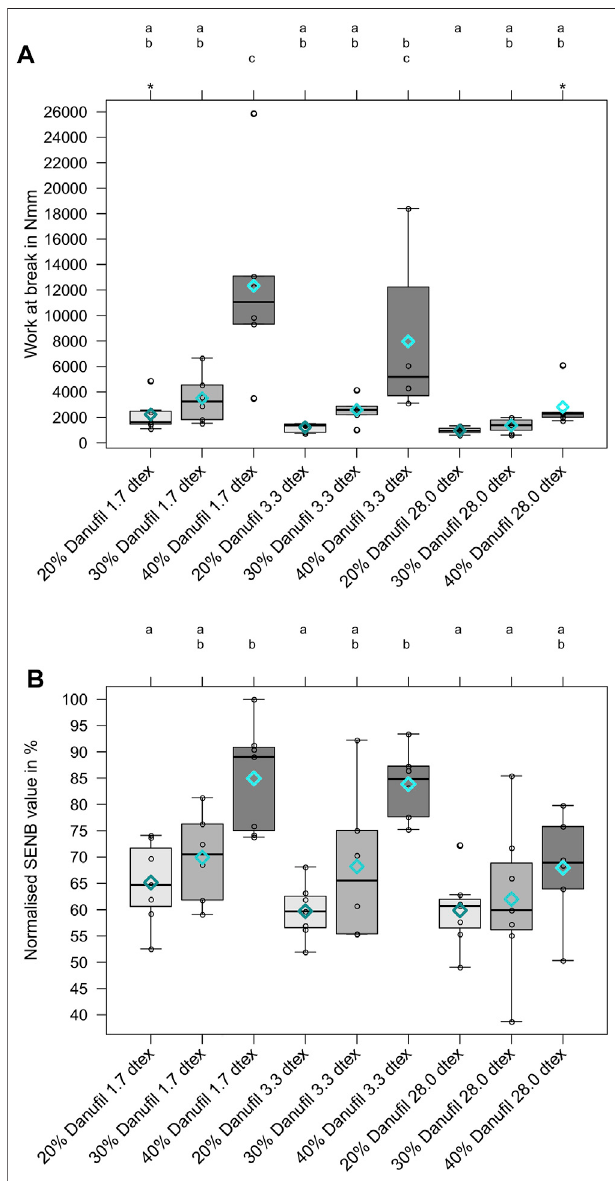
FIGURE 7 | Work at break determined from force-displacement curves of tensile tests (A) and SENB value normalised to the highest value obtained by a single edge notched bending test. (B) Results are shown as Box- Whisker-Plots with the mean values as rhombuses. Different letters indicate signi fi cant differences. A * marks results which do not follow a normal